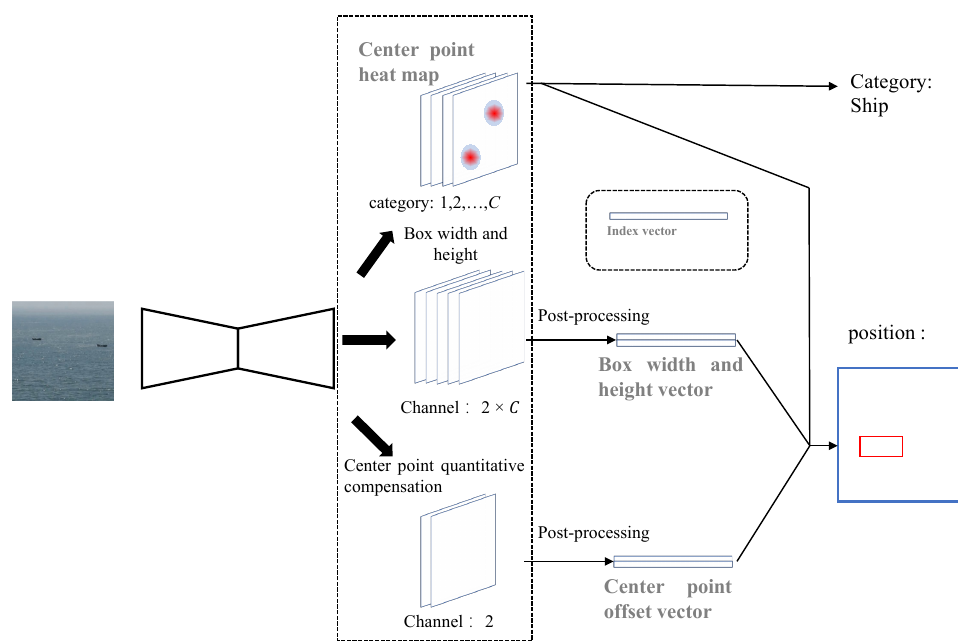
Figure 5. Schematic diagram of CenterNet detection